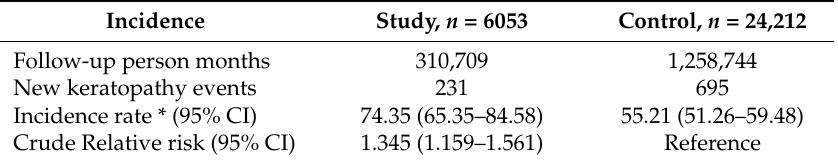
Table 2. The incidence of keratopathy in the study and control groups.